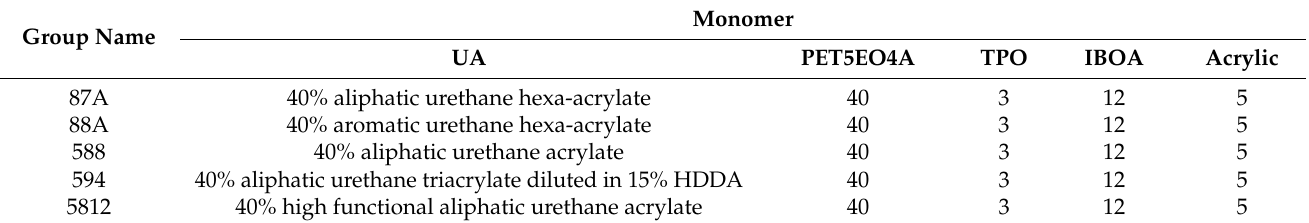
Table 1. Preparative percentages (wt%) of 5 urethane acrylate-based photopolymer